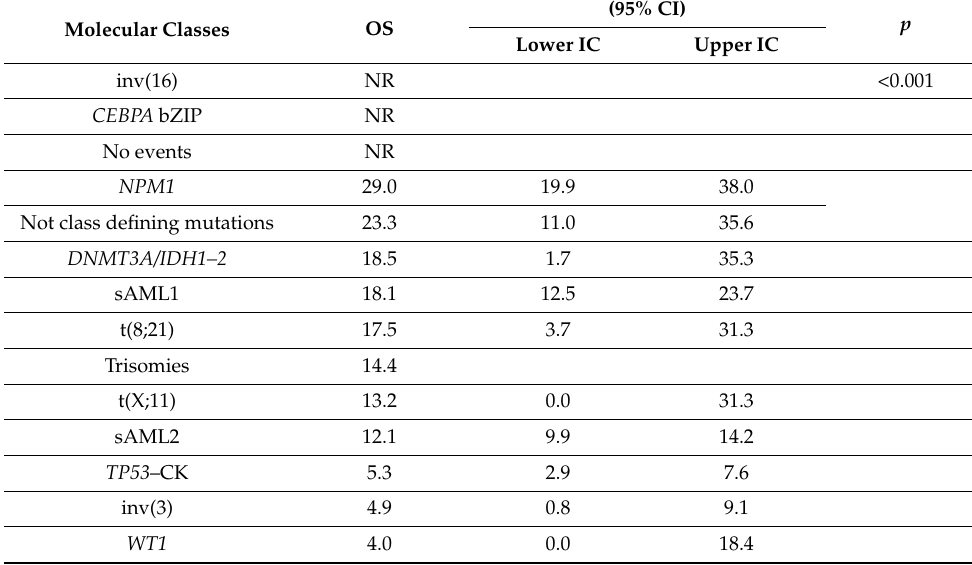
Table 2. Median overall survival and 95% CI for molecular AML classes.